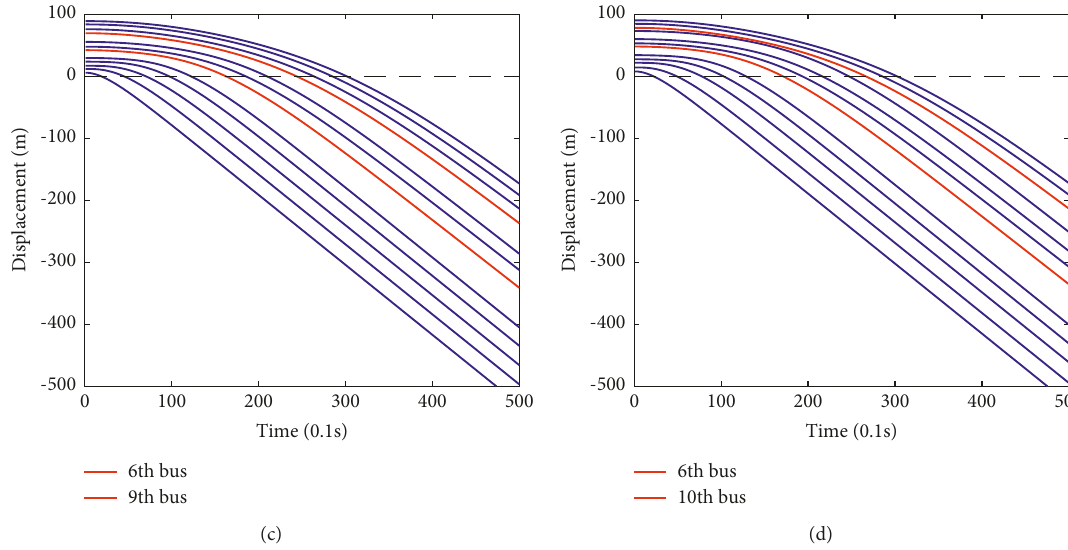
Figure 19: The numerical simulation diagram in 10–20% heavy vehicles scenario. (a) The bus at the 6th and 7th positions. (b) The bus at the 6th and 8th positions. (c) The bus at the 6th and 9th positions. (d) The bus at the 6th and 10th positions.